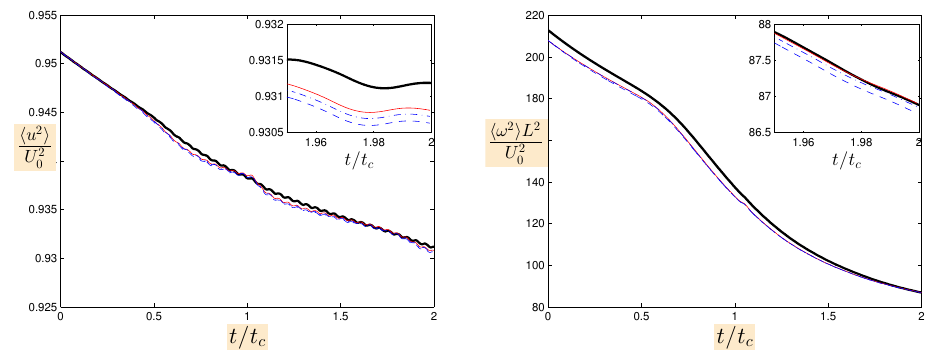
Figure 8. Double shear layer, Ma = 0.0693, Re = 3 × 10 4 . The kinetic energy (upper plot) and squared vorticity (lower plot) are presented. The benchmark solution is denoted as ( − ) ; the low- dissipative entropic method is denoted as ( − ) ; the third-order EELB method is denoted as ( −− ) ; the method of Zhao and Yong is denoted as ( − · − ) . For all entropic models, the grid resolution is 256 ×